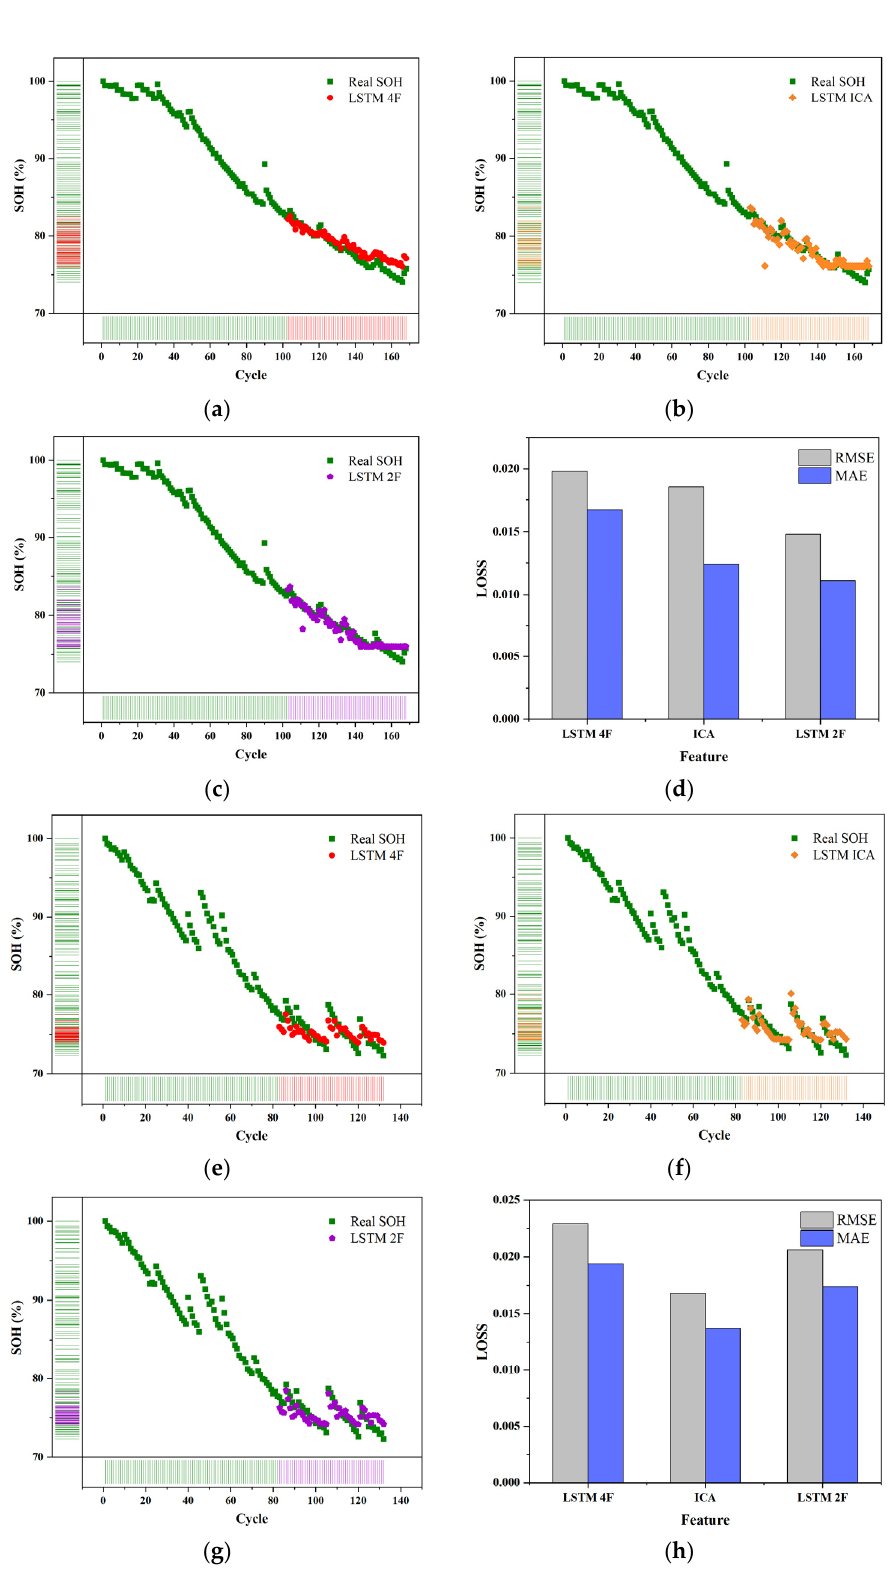
Figure 6. LSTM for 7# and 18# batteries ( a – c ). The predicted results of different features for 7# ( d ). The loss of battery 7# ( e – g ). The predicted results of different features for 18# ( h ). The loss of battery 18#.